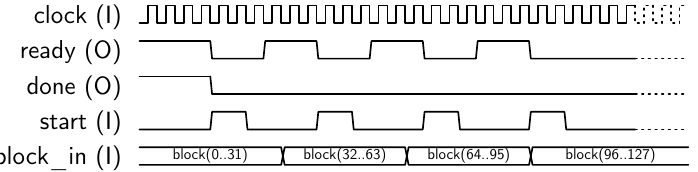
Figure 6. Sequence for block input.